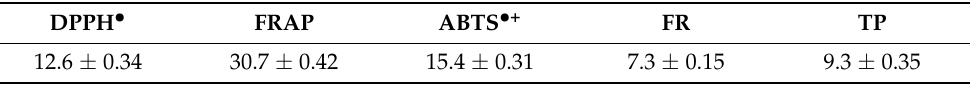
Table 1. Antioxidant activity and total polyphenolic compound content of the extract from seeds of the Cerason variety.